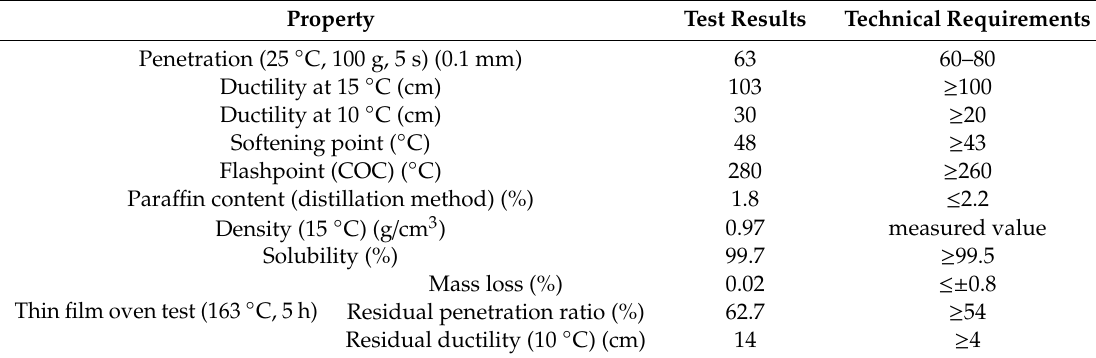
Table 1. Technical properties of base asphalt binder 70 # .